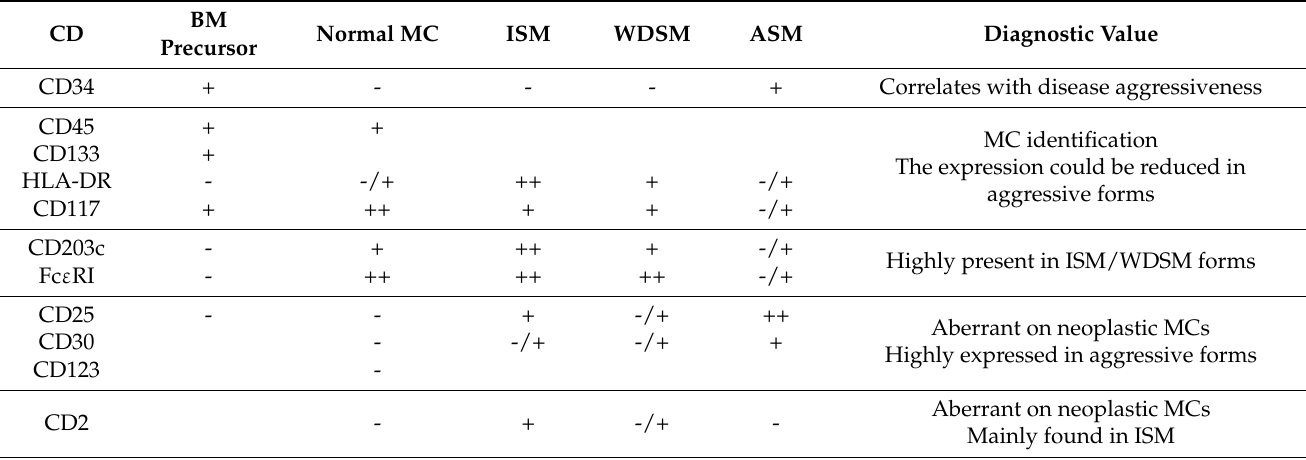
Table 4. Normal and neoplastic MC